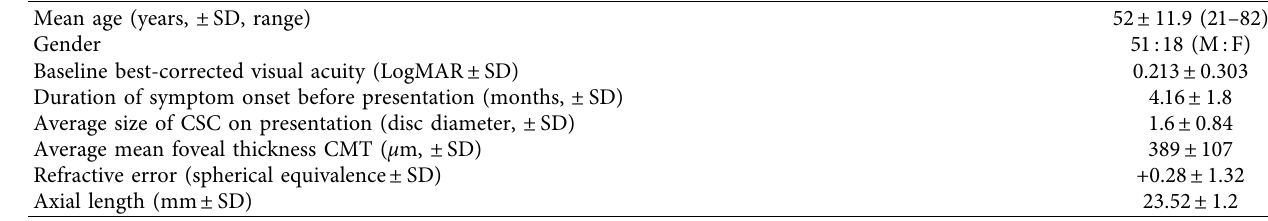
Table 1: Baseline demographic